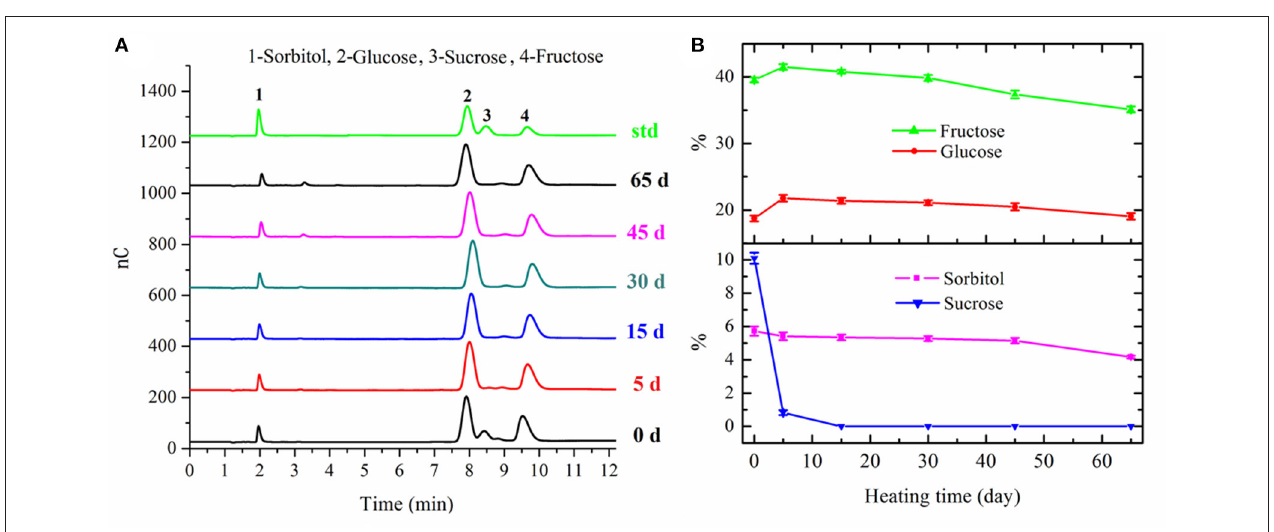
FIGURE 2 | Chromatograms of sugars in apple samples with different fermentation days (A) and changes in sugars of apple during 65-day HTFP process (B) .